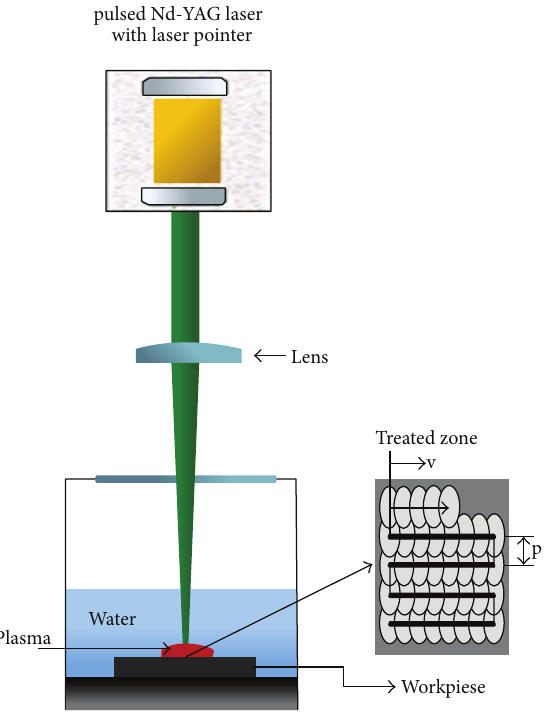
Figure 2: Schematic diagram of the experimental setup of (LSP) and the irradiation pattern on a sample.